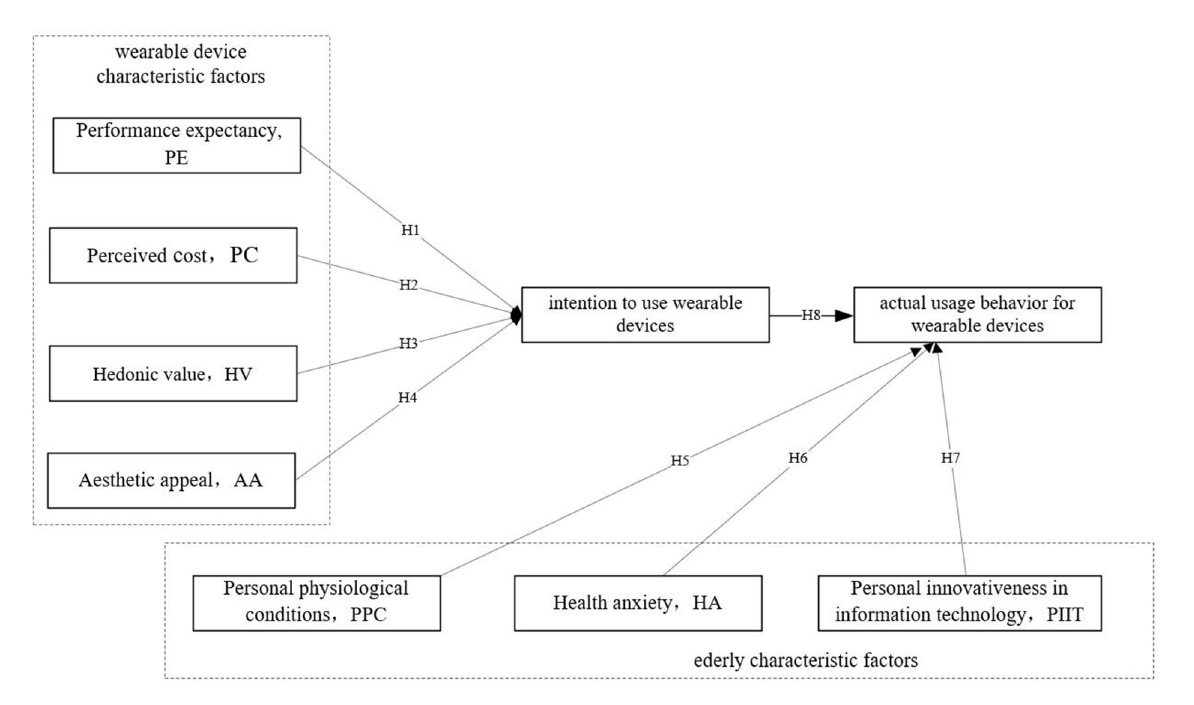
FIGURE1 Proposed improved UTAUT in the present